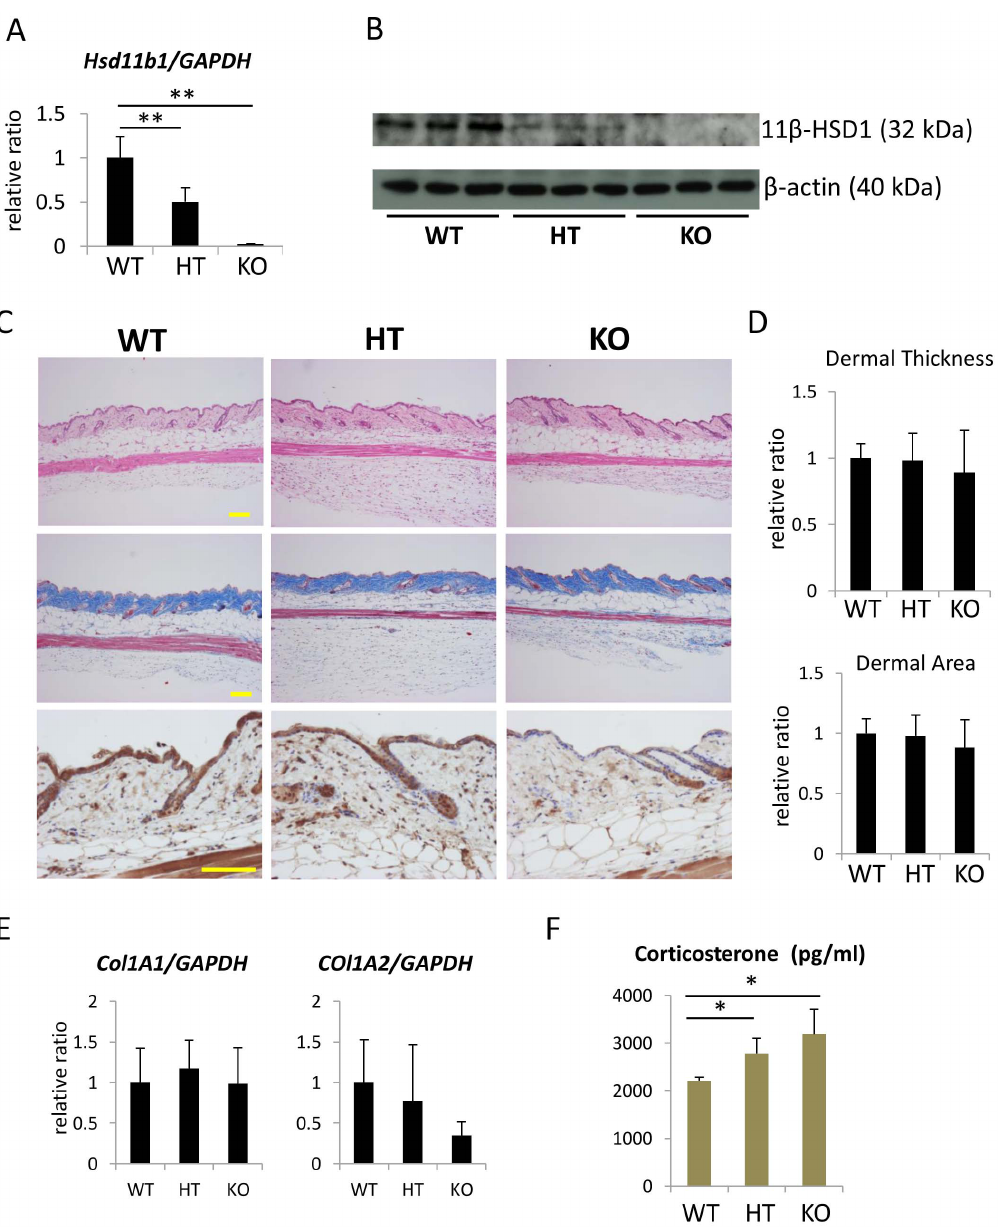
Figure 5. Generation of 11 b -HSD1 knockout mice. (A) The relative expression of 11 b -HSD1 in WT, HT, and KO mouse skin extracts was assessed with rtPCR. GAPDH was used as an internal control. **P , 0.01, one-way ANOVA followed by the Bonferroni-Dunn test for multiple comparisons. (B) Western blot analysis of 11 b -HSD1 in WT, HT, and KO mouse skin extracts. (C) H&E staining (upper panel), Masson’s trichrome staining (middle panel), and 11 b -HSD1 staining (lower panel) in 3-month-old WT, HT, and KO mouse skin. Bar =100 m m. (D) Dermal thickness was calculated by averaging the thickness measured at five locations in each section. Three sections from each mouse were evaluated. The dermal area in each mouse was measured using Image J. Bars show the mean epidermal thickness 6 SD (N=4). (E) The relative expression of Col1A1 and Col1A2 in 3-month-old WT, HT, and KO mouse skin. GAPDH was used as an internal control. Bars indicate the mean 6 SD (N=6). (F) Plasma corticosterone levels in WT, HT, and KO mice were measured with ELISA. Bars indicate the mean 6 SD (N=6; *P , 0.05, one-way ANOVA followed by the Bonferroni-Dunn test for multiple comparisons).